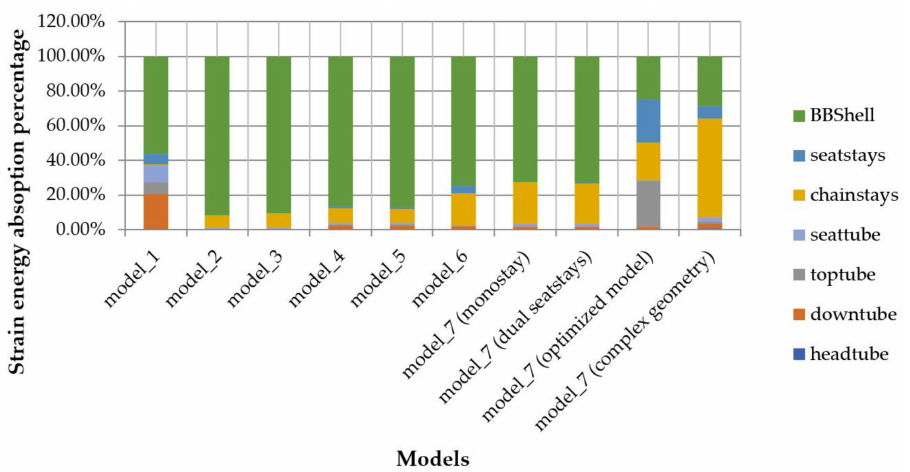
Figure 23. Absorption of strain energy and its distribution in a static start-up scenario.